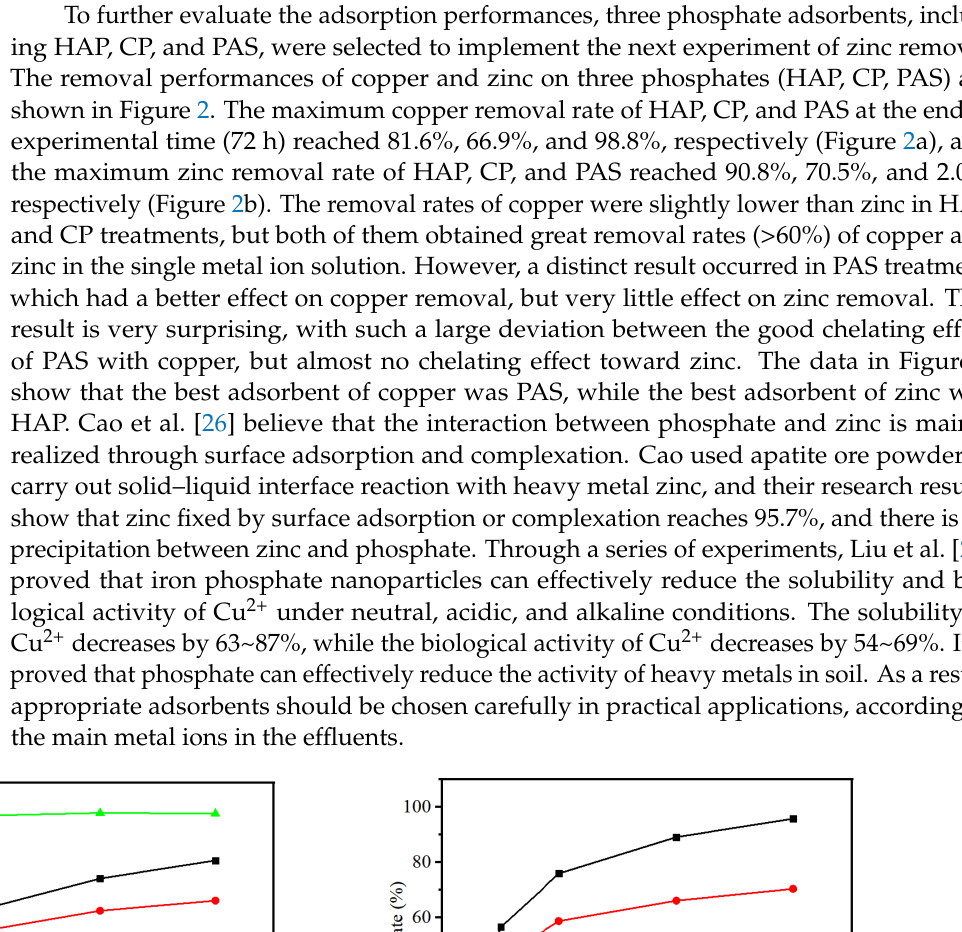
Figure 1. The concentration variation of Cu 2+ in six phosphate treatments within 0 to 72 h.